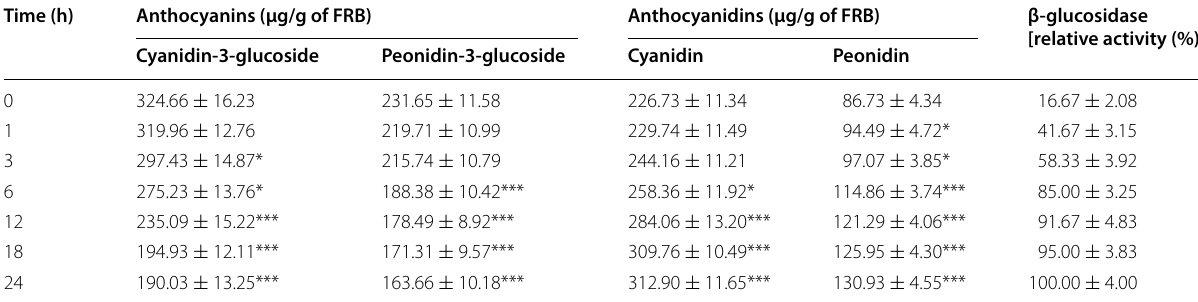
The significant difference between the anthocyanins (cyanidin-3-glucoside or peonidin-3-glucoside) or anthocyanidins (cyanidin or peonidin) at different time points (1, 3, 6, 12, 18, and 24 h) during fermentation and the respective anthocyanins or respective anthocyanidins at 0 h of fermentation were represented as * (p < 0.05), ** (p < 0.01), and *** (p < 0.001)